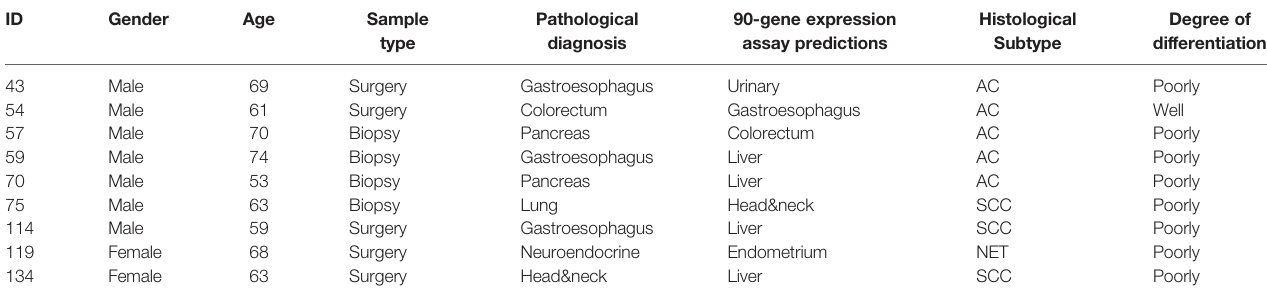
TABLE 3 | Investigation of nine cases misclassi fi ed by the 90-gene expression